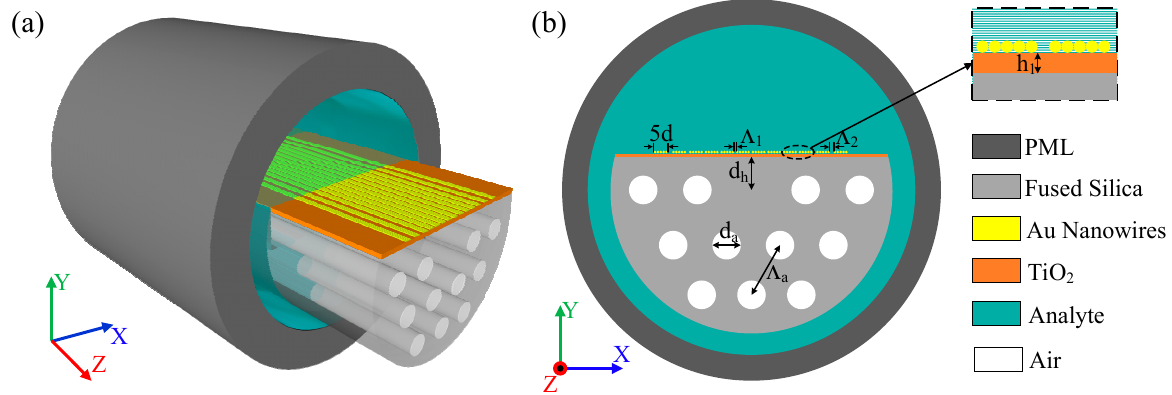
Figure 1. Fiber optic sensor structure model. ( a ) Three-dimensional model; ( b ) two-dimensional cross section.